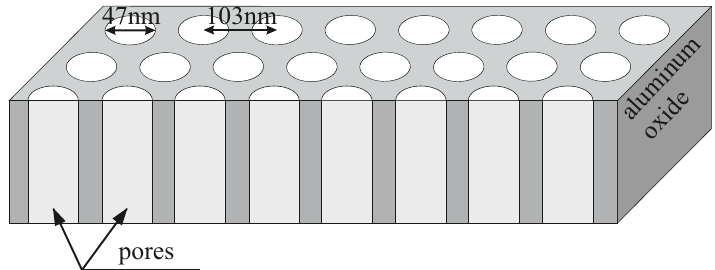
Figure 1. The schematic representation of the structure of an anodised aluminium oxide